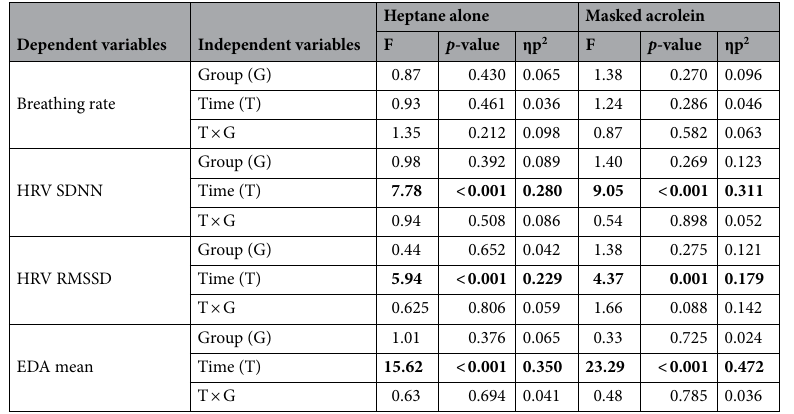
Table 6. Results from the two-way mixed ANOVAs with Time (16 measuring points) as the within-subjects variable and Group (referents/BRS cases/BRS + CI cases) as the between-subjects variable and with autonomic nervous system responses as the dependent variables in the heptane alone and masked acrolein exposure conditions. Significant values are in